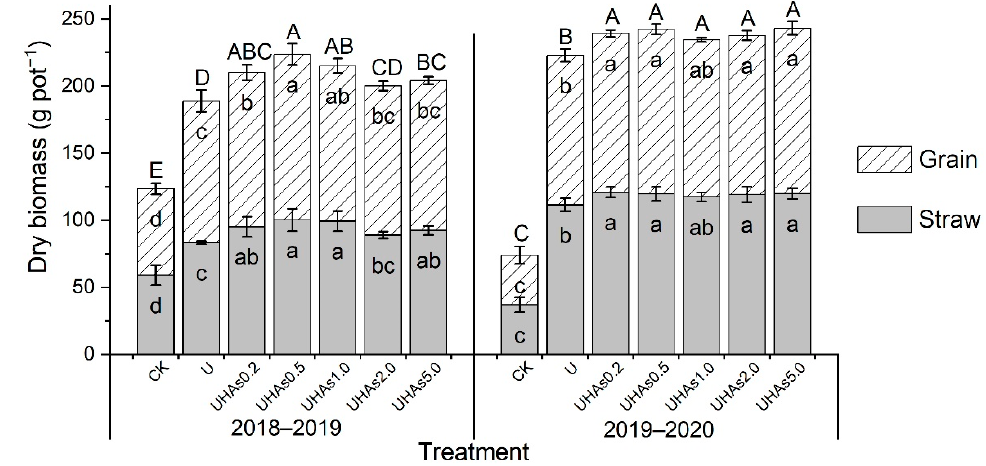
Figure 3. Aboveground dry biomass of mature winter wheat under different proportions of HAs in urea fertilizer formulations. Treatments with no letter in common were significantly different at p < 0.05, as indicated by LSD test. Capital letter above columns resulted from the differences of total aboveground parts of mature winter wheat among treatments.